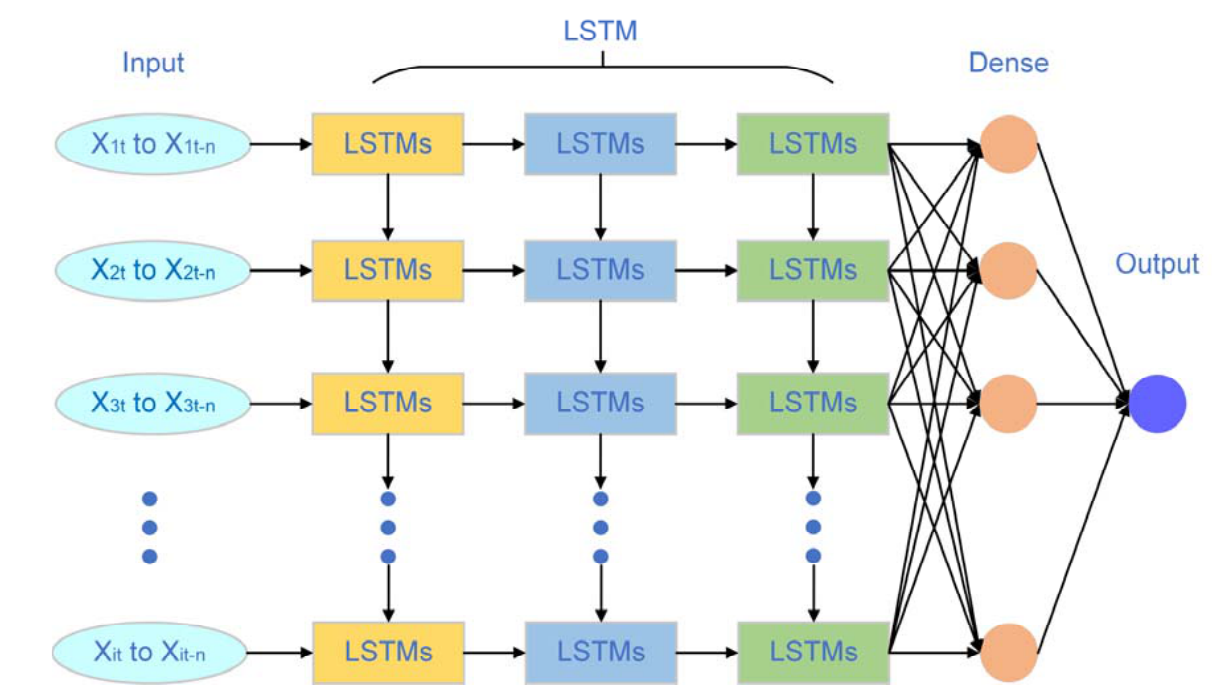
Figure 6. The frame of the LSTM network for regression problems.